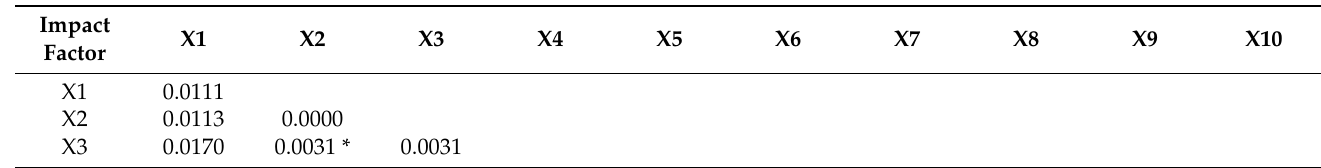
Table 4. Interaction of 10 impact factors of Benggang